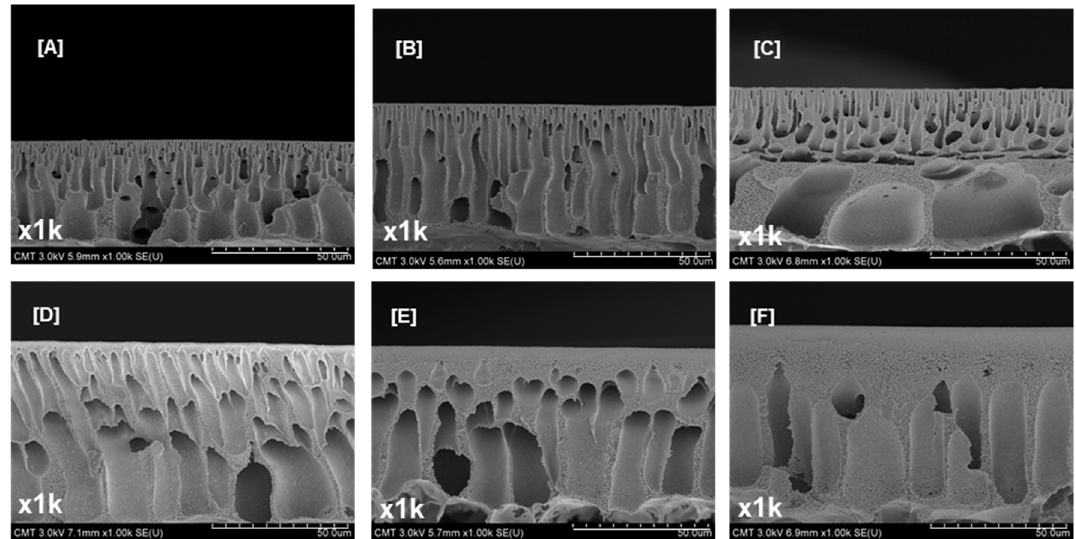
Figure 3. Cross-sectional images of PSf supports modified using PEG of varying molecular weights: